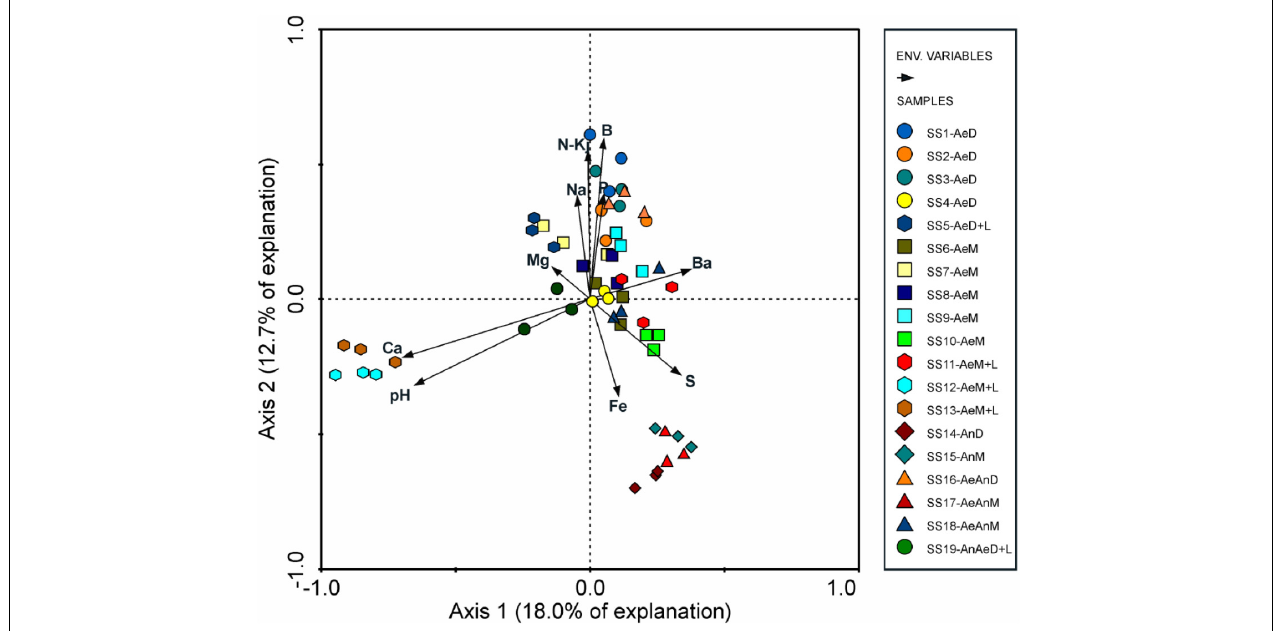
FIGURE 4 | Redundancy analysis (RDA) between chemical attributes and bacterial community of 19 sewage sludges from São Paulo State, Brazil ( n = 3